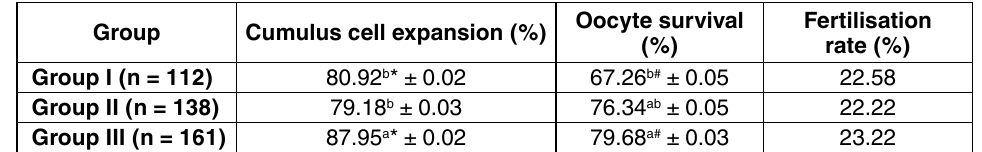
table 1. Effect of supplementation of L carnitine and niacin on cumulus cell expansion,